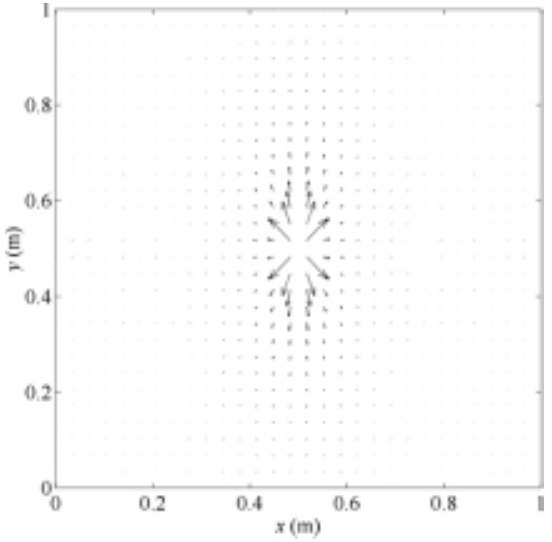
Fig. 18. The approximate intensity field in the orthotropic plate when f = 5 kHz and η = 0 . 2